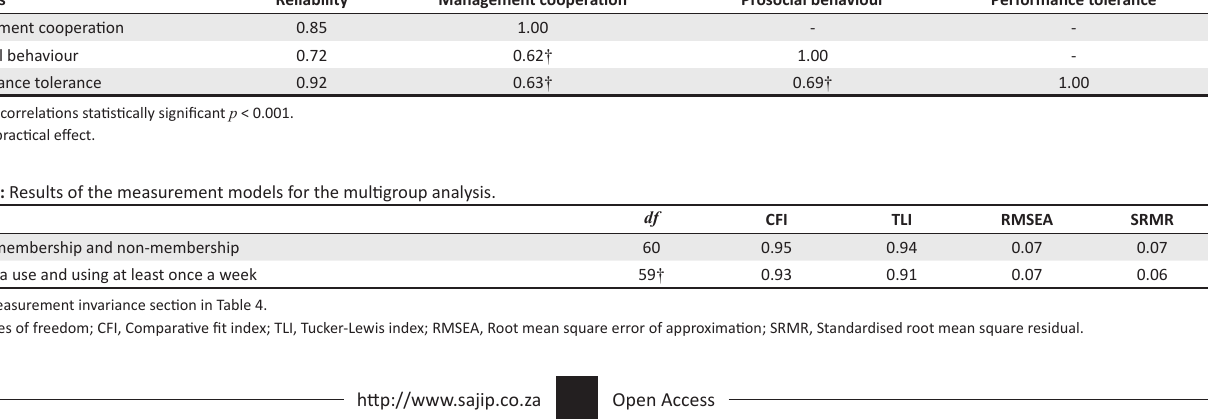
TABLE 2: Reliabilities and correlation matrix for the latent variables of fan engagement. Variables